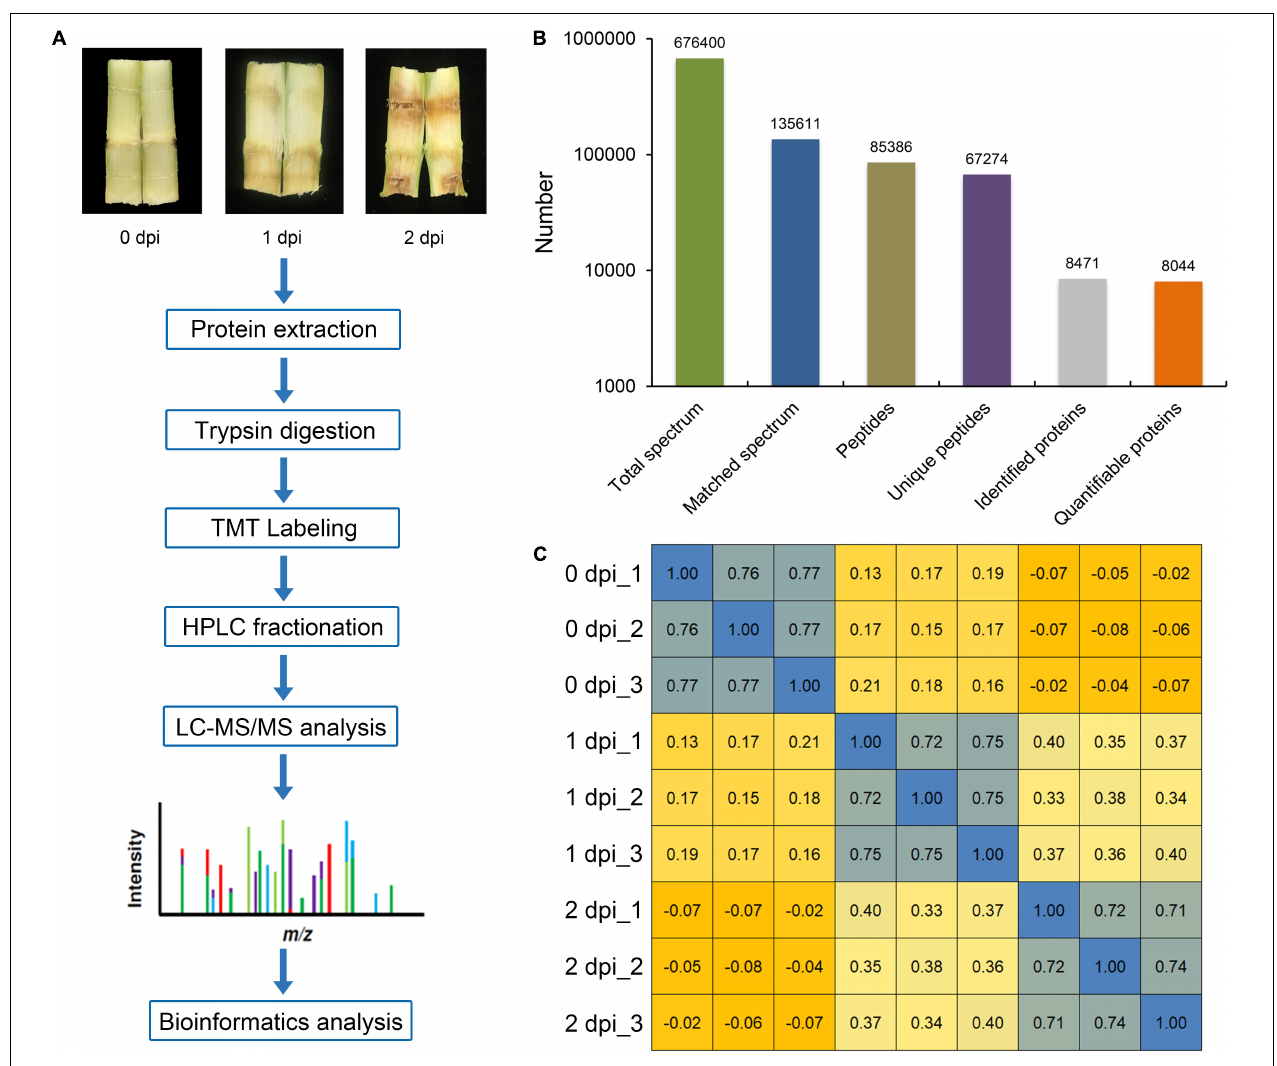
FIGURE 1 | Overview of treatments and proteome profiling. (A) Differentially expressed proteins (DEPs) were quantified and analyzed by tandem mass tag (TMT) labeling and LC-MS/MS. (B) Summary of sampled spectra, peptides, acetylated peptides, and identified proteins. (C) Pearson correlation statistics of the replicates of every